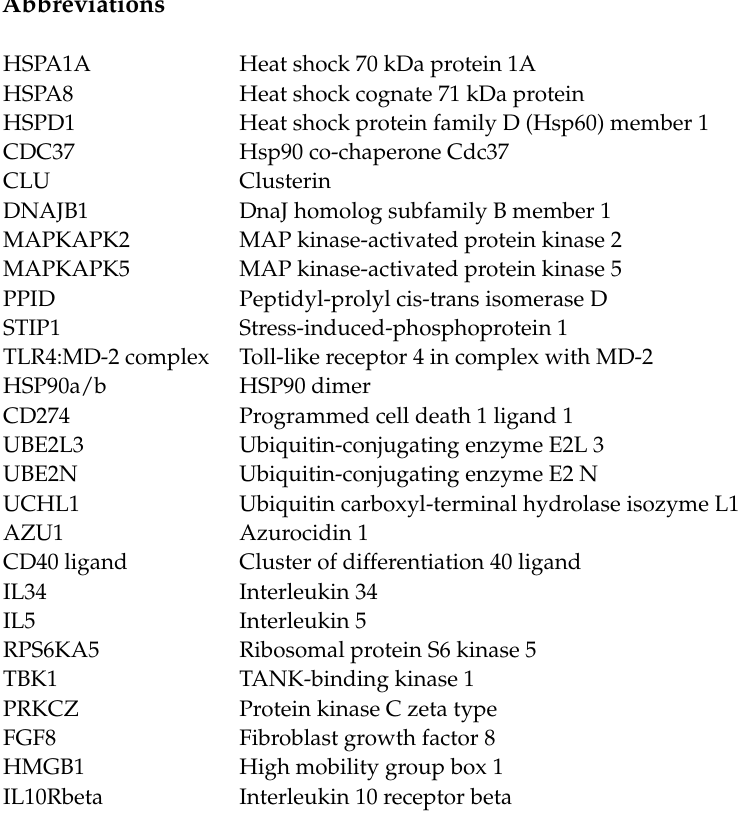
Table S1: Inflammatory protein panel for all proteins for the type 2 diabetes patients, p value and fdr value (<0.05 fdr was considered